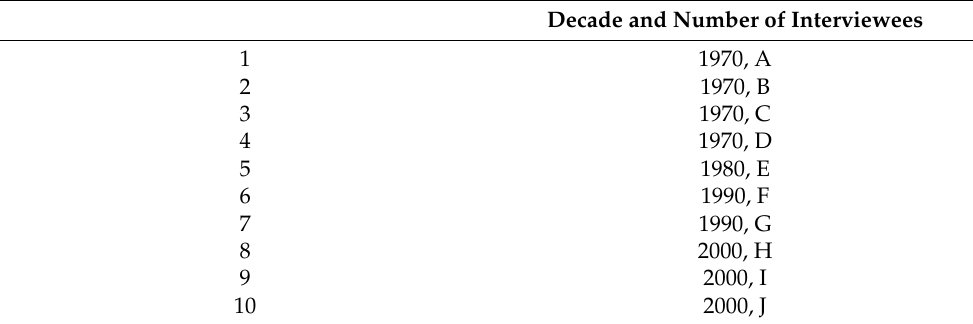
Table 1. Decade and number of